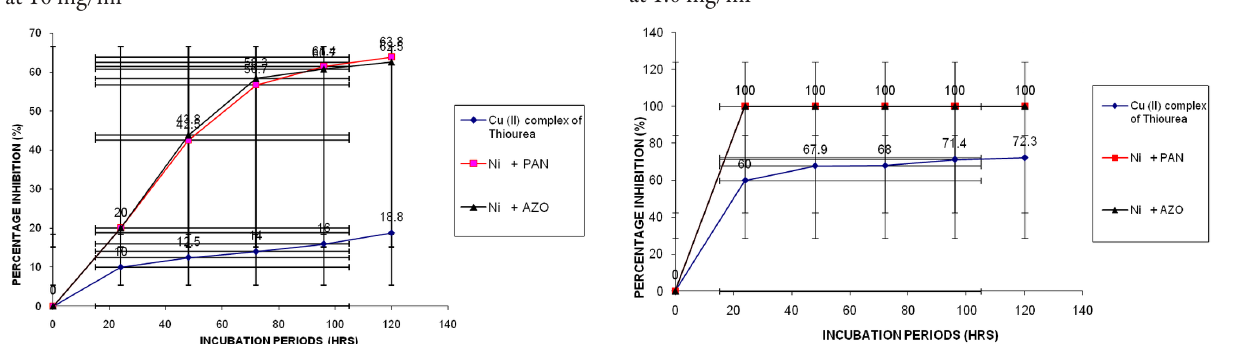
Fig. 3. Reduction of Mycelial growth of Geotrichum candidum at 0.1 mg/ml